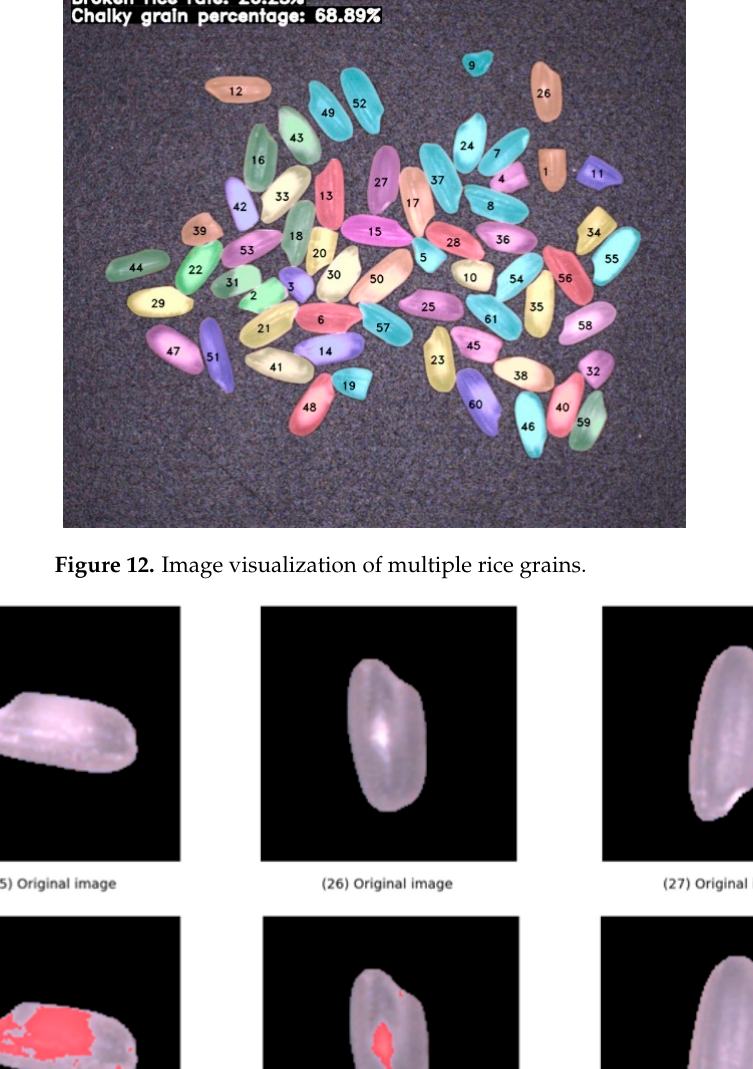
Figure 11. Confusion matrix of rice grain types before improvement.